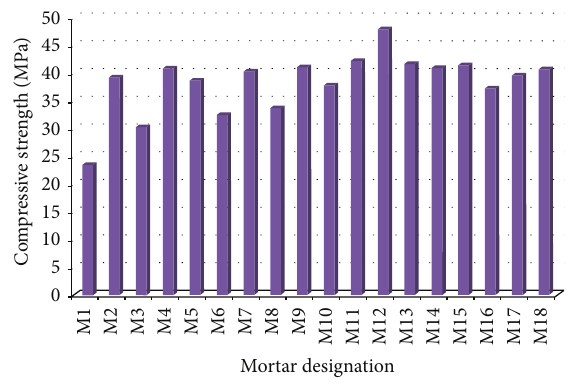
Figure 15: 28-day compressive strength of different mixes.